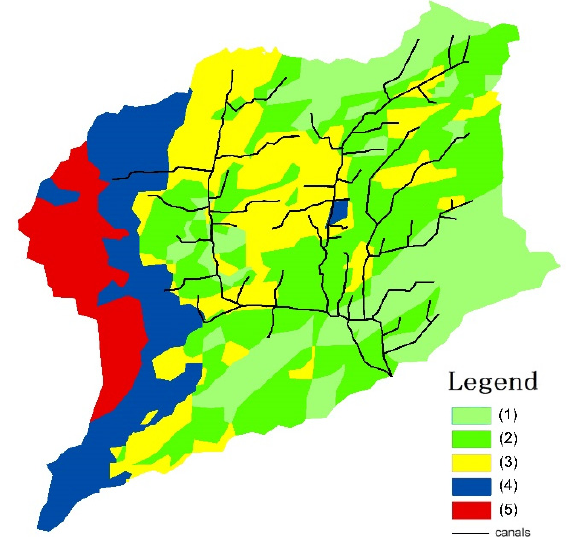
Figure 9. Adaptability zoning map of recharge and existing canal system in the Yellow River Irrigation District of Liaocheng City.